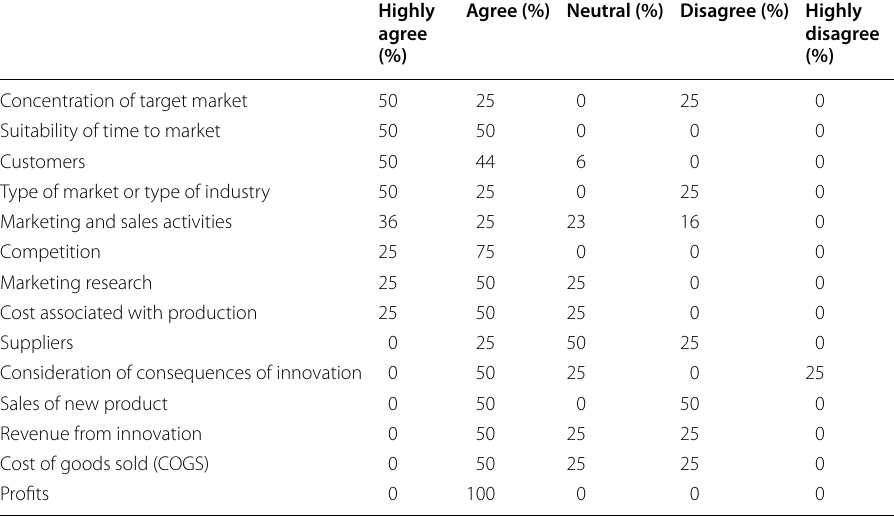
Table 5 Survey results in percentage of response related to market-related